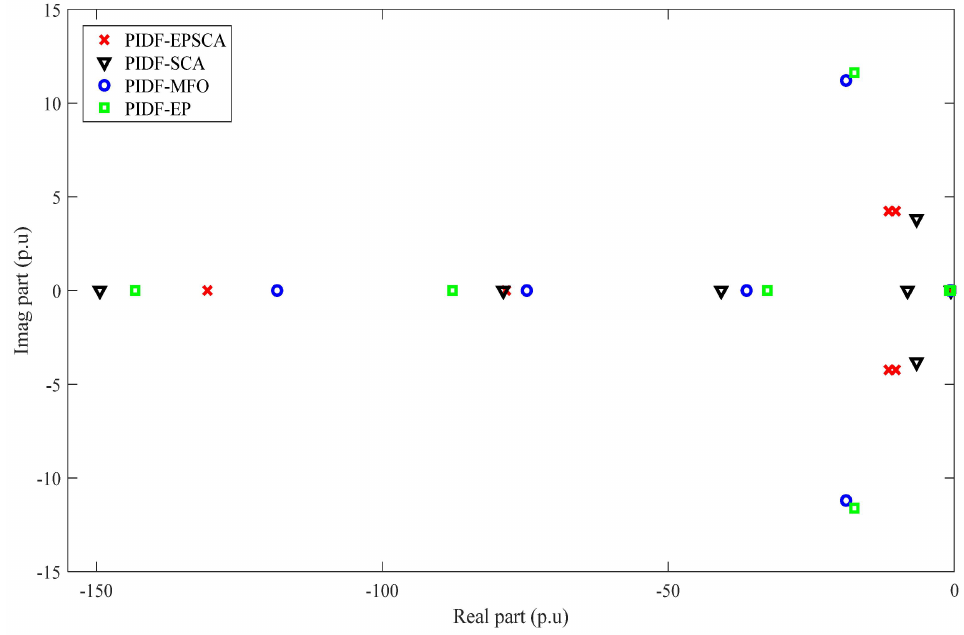
Figure 20. Eigenvalue distribution of TCSC-PIDF controller system using PIDF-EPSCA, PIDF-SCA, PIDF-MFO, and PIDF-EP techniques for Scenario A-2.